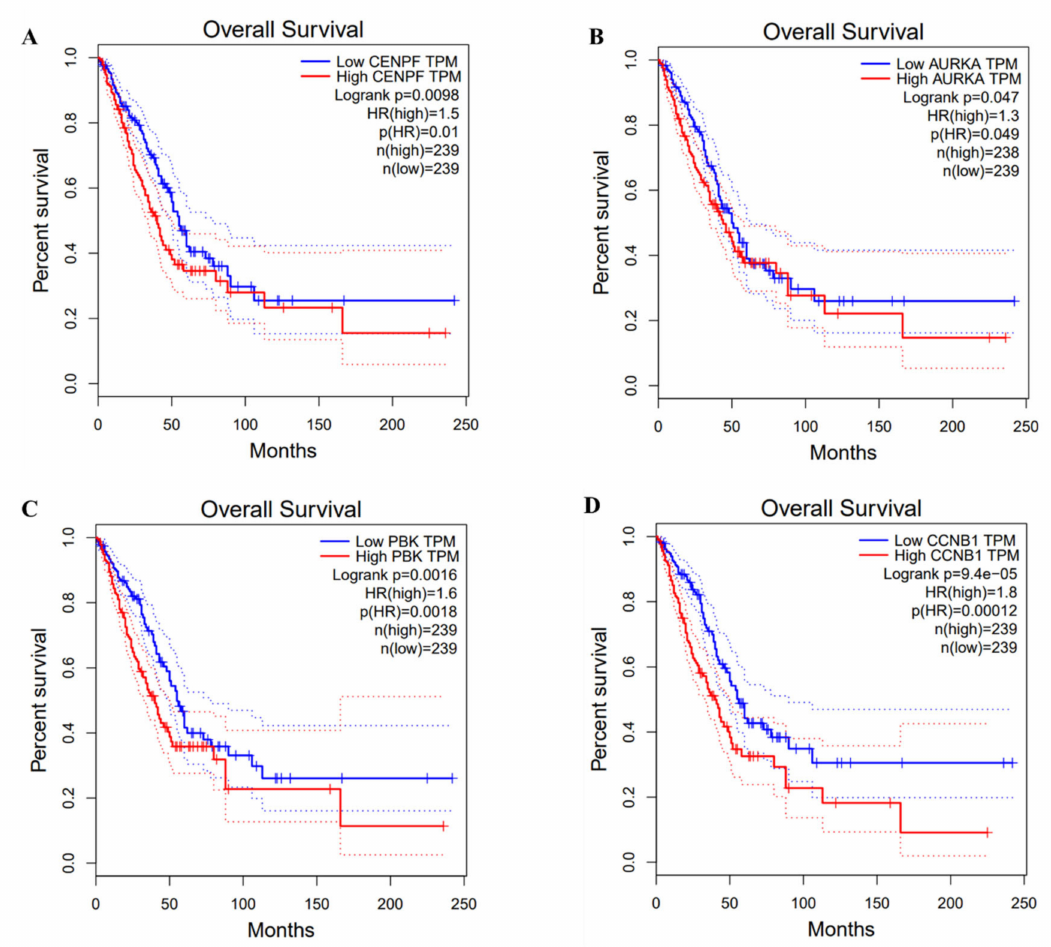
Figure 8. Survival analysis of hub genes and lung